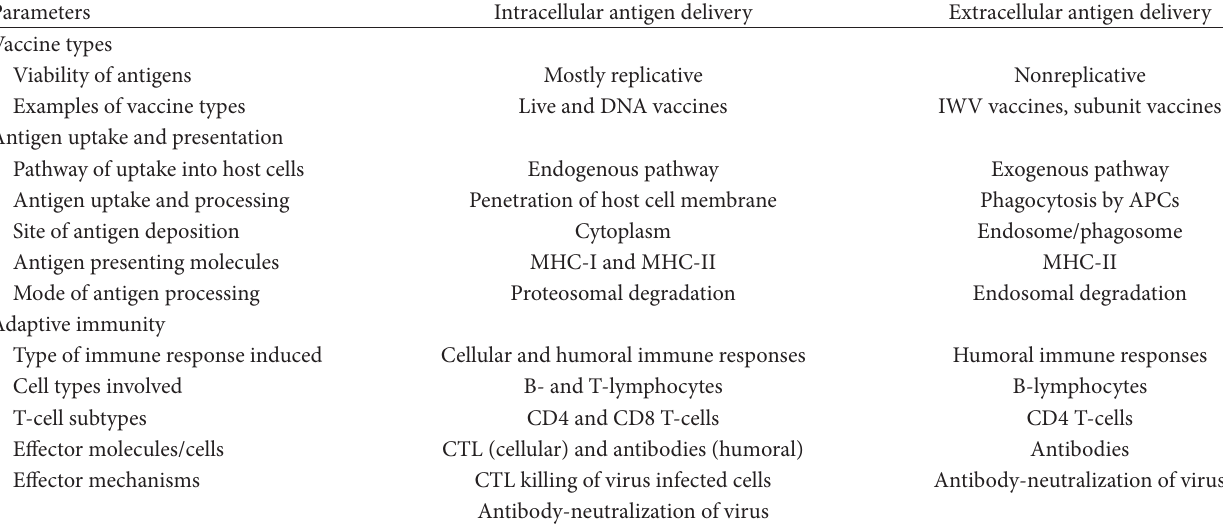
Table 8: Comparison of the intra- and extracellular antigen processing